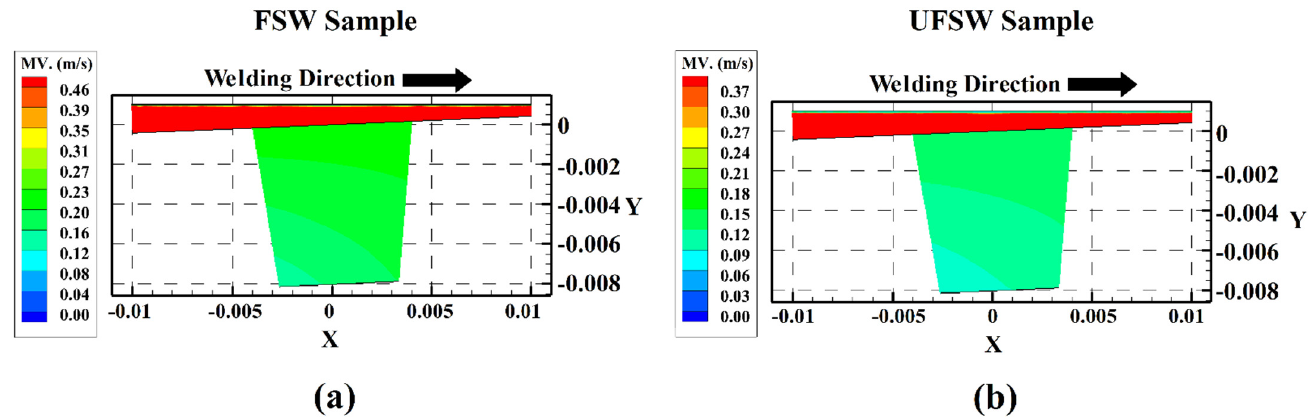
Figure 6. Side view of simulation results from materials velocity in ( a ) FSW and ( b ) UFSW sam-